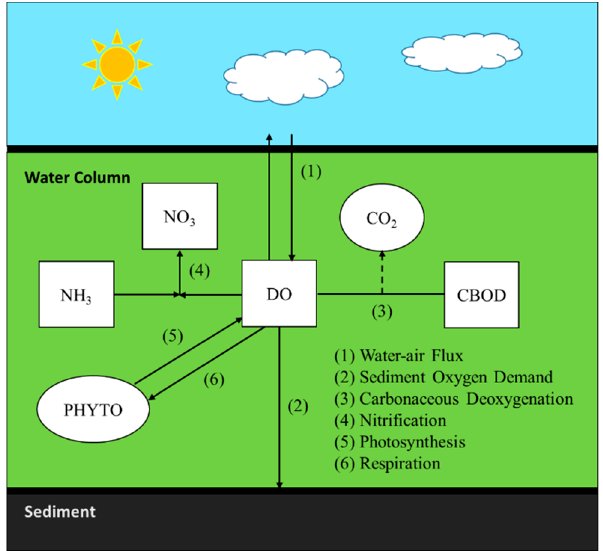
Figure 3. Schematic description of the processes involved in the DO balance (modified from the WASP user’s manual [27]).